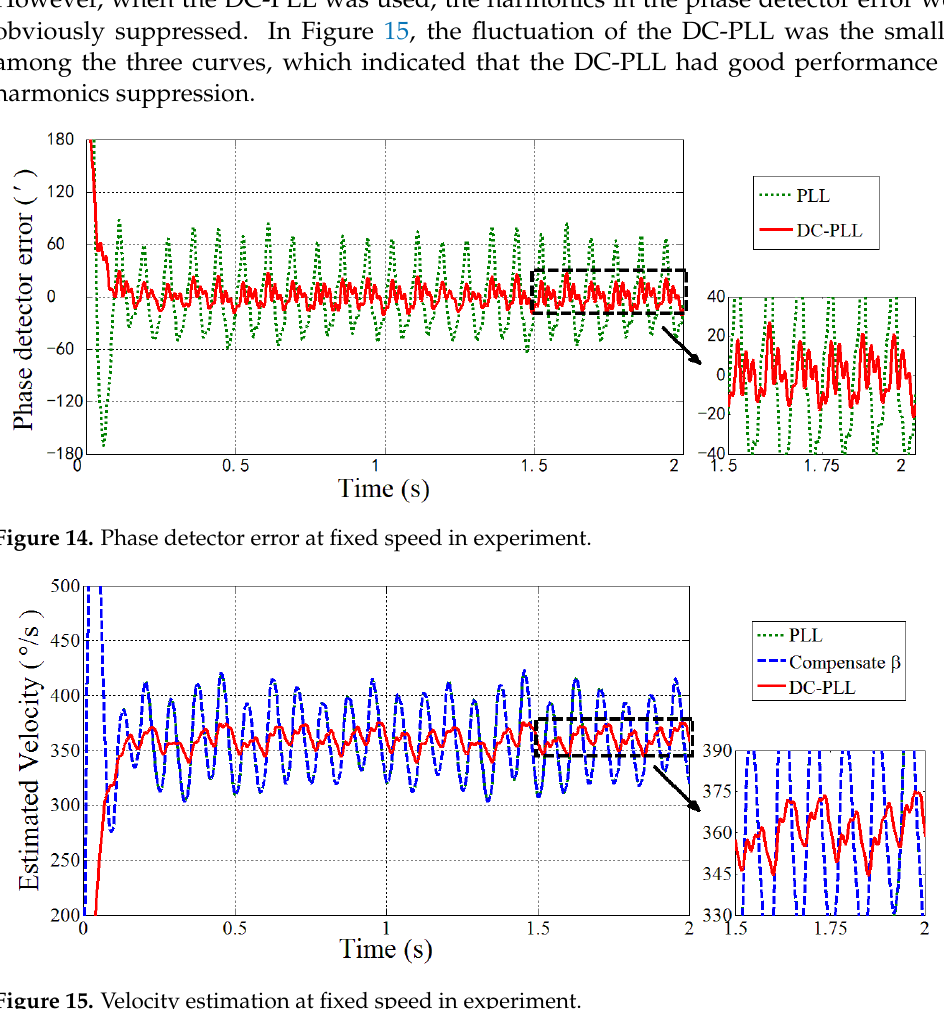
Figure 15. Velocity estimation at fixed speed in experiment. Table 4. The statistics of experiment demodulation results.